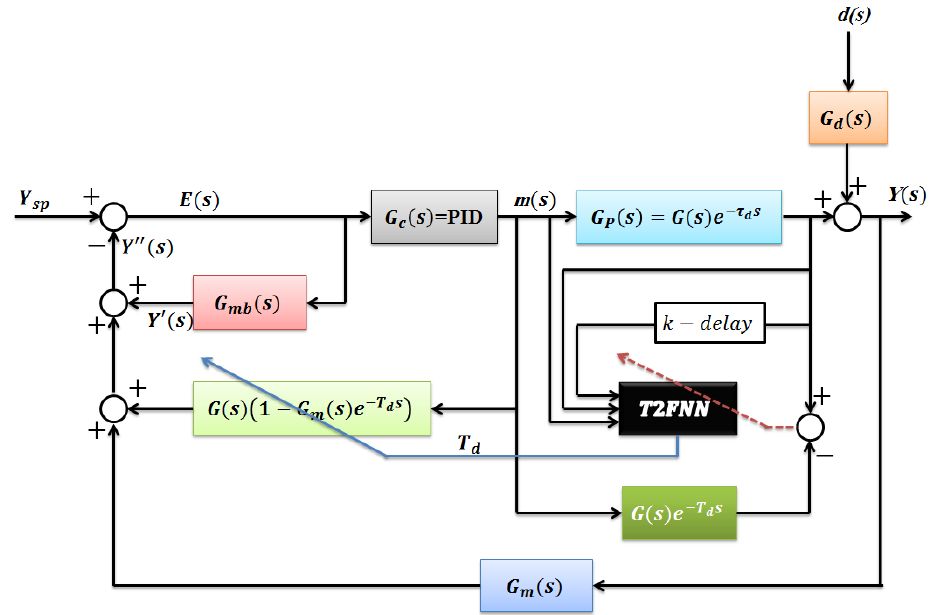
Figure 3. The proposed control system.